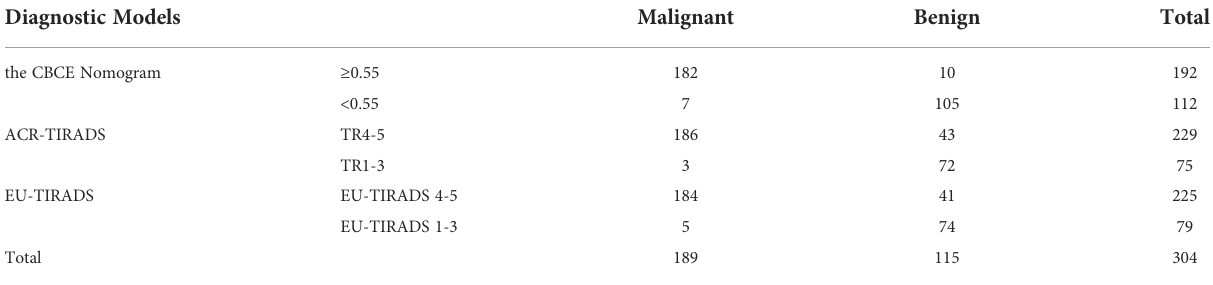
TABLE 3 Numbers of cases according to the cut-off values in the three models based on the validation group.